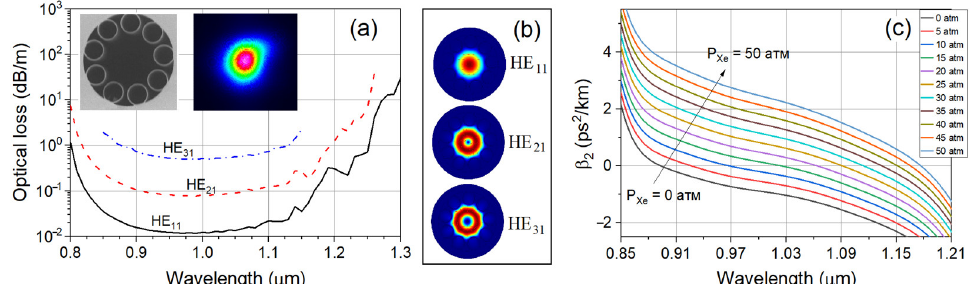
Figure 2. ( a ) Optical loss spectrum calculated for the fundamental (HE 11 ) and two higher-order modes of the fiber (HE 21 and HE 31 ). The SEM-image of the revolver fiber cross-section is shown on the left inset. Near-field intensity distribution measured at the fiber output is shown on the right inset. ( b ) The calculated intensity distributions for the lowest order modes (HE 11 , HE 21 , HE 31 ) of the fiber. ( c ) Group velocity dispersion β 2 of the fundamental mode as a function of wavelength at various xenon pressures.